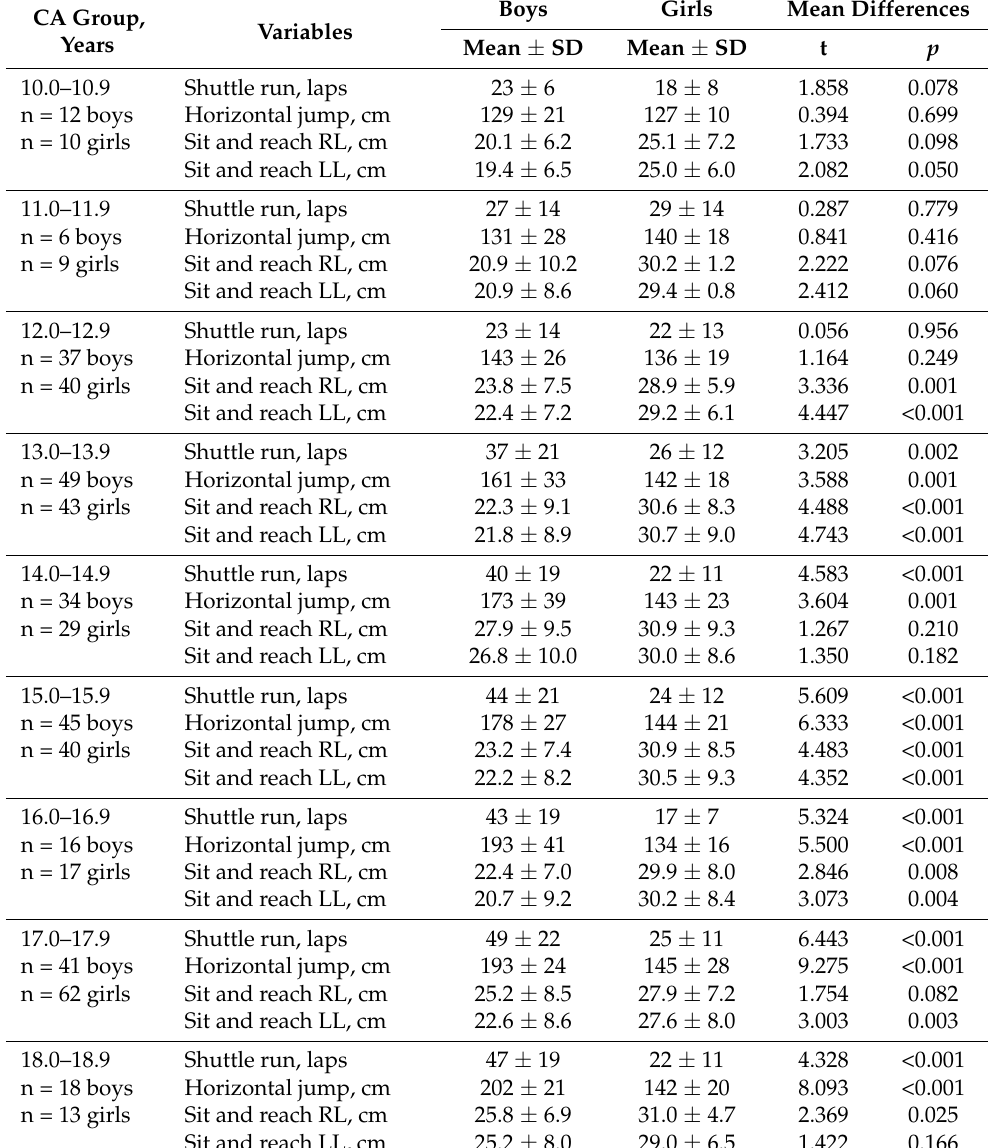
Table 2. Descriptive statistics of physical fitness tests and comparisons by sex within age